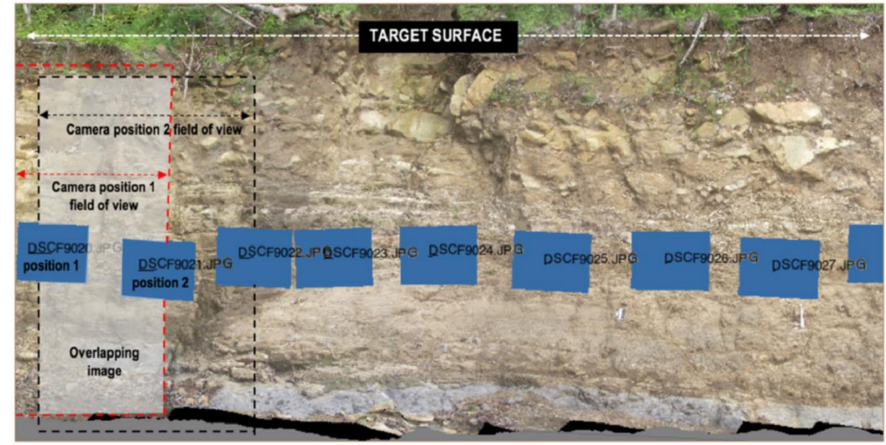
Figure 7. Stereoscopies images in structure from motion (SfM).